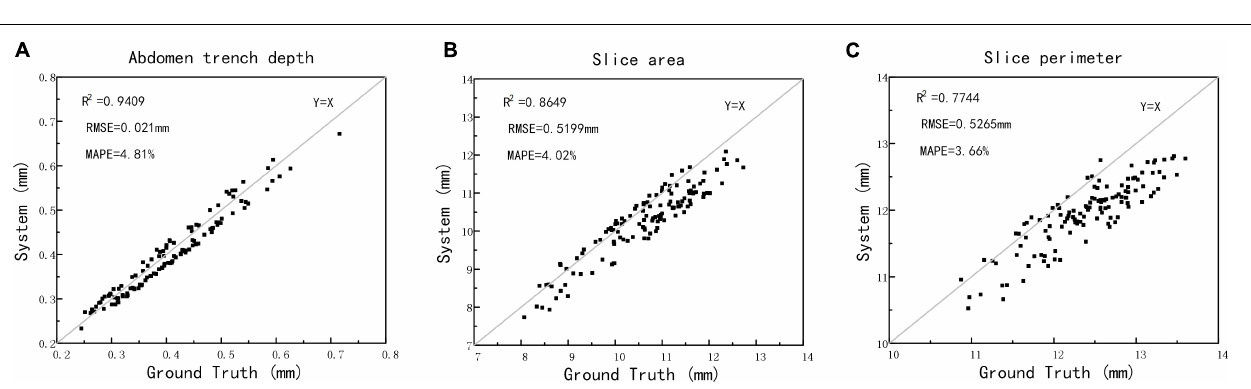
FIGURE 7 | The automatic measurements vs. manual measurements of length, width, and thickness using structured light imaging (A–C) and X-ray CT imaging (D–F) .